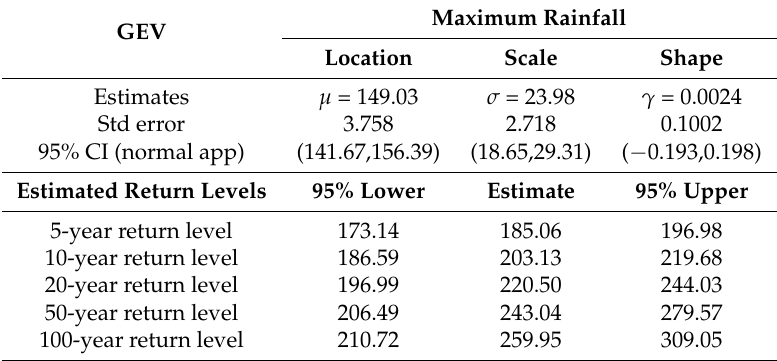
Table 5. Generalised extreme value estimates of maximum